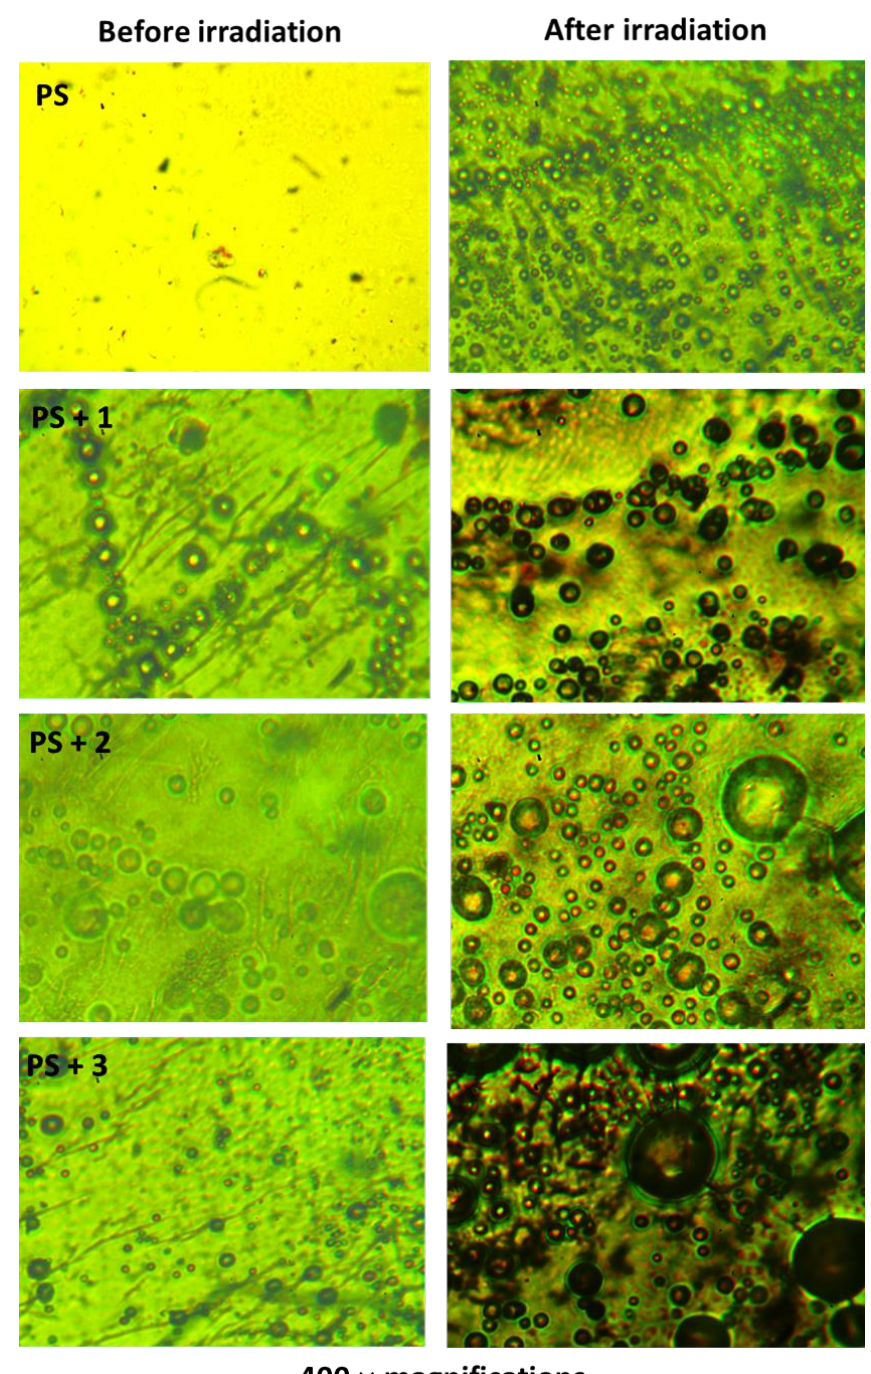
Figure 10. Microscopic images of PS and PS/Schiff bases 1 – 3 blends before and after irradiation.